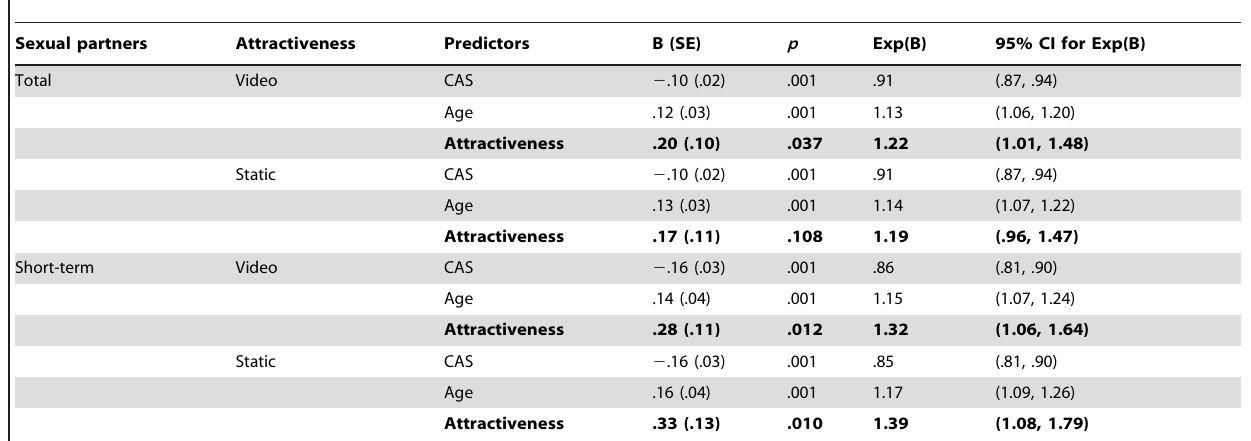
Table 3. Video-attractiveness and static-attractiveness as predictors of mating success (number of sexual partners), controlling sexual attitudes (CAS) and age, using GZLM ( N